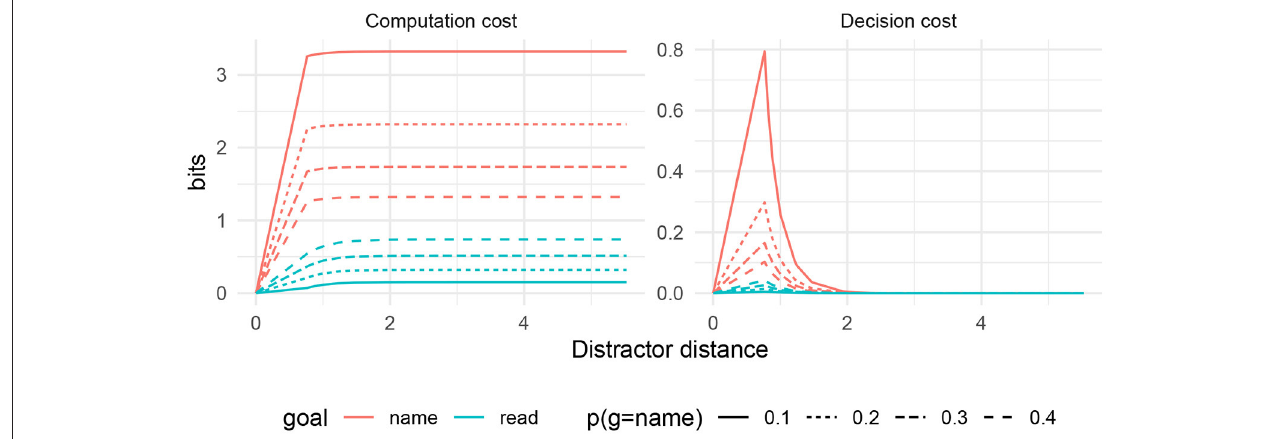
FIGURE 6 | Computation and decision cost for PWI under varying values of p name . A reverse Stroop effect emerges in the decision cost under the reading